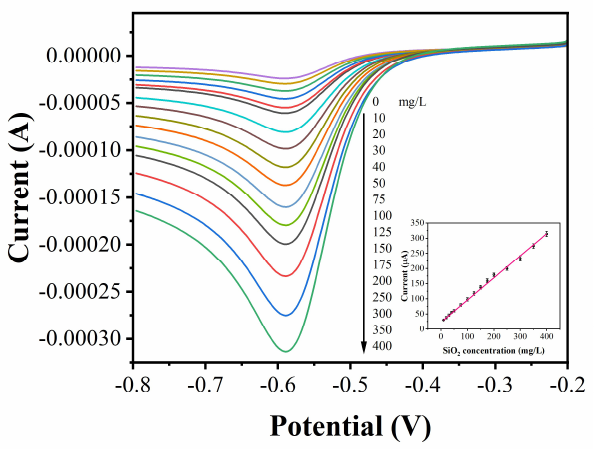
Figure 3. LSV profiles of Ag/Si/GCEs prepared using 10–400 mg/L of SiO 2 for electrocatalytic reduction of 0.5 mM H 2 O 2 in 0.1 M PBS (pH = 7.0).